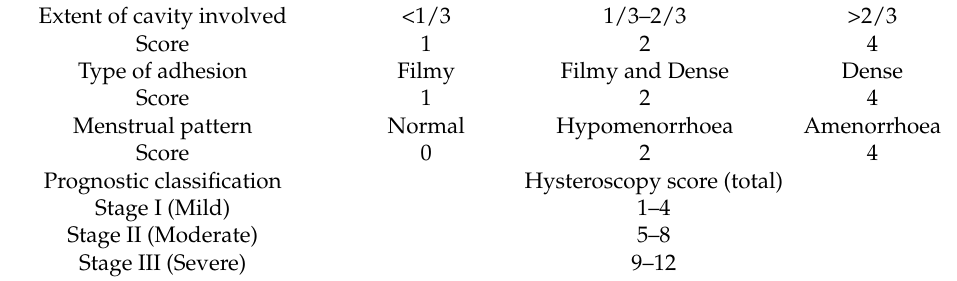
Table 1. The American Fertility Society classification of IUA, 1988 [8]. Extent of cavity involved